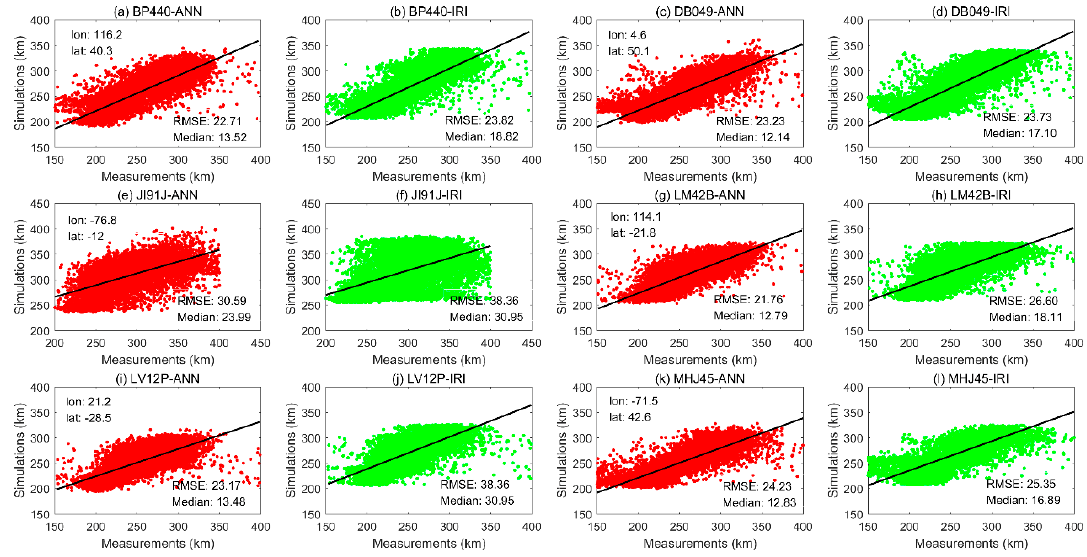
Figure 5. Similar to Figure 4, but for hmF2.